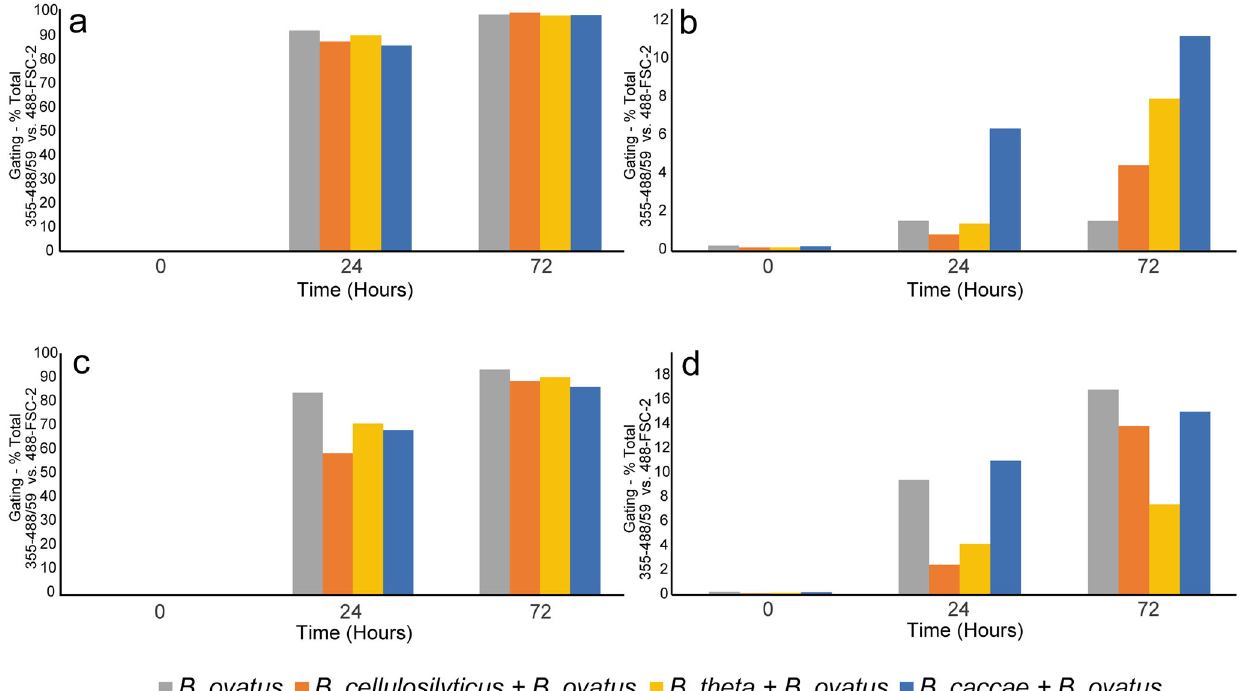
Fig. 9 Screening of labelled glycan uptake as a function of substrate speci fi city in co-cultured bacterial fermentations measured by fl ow